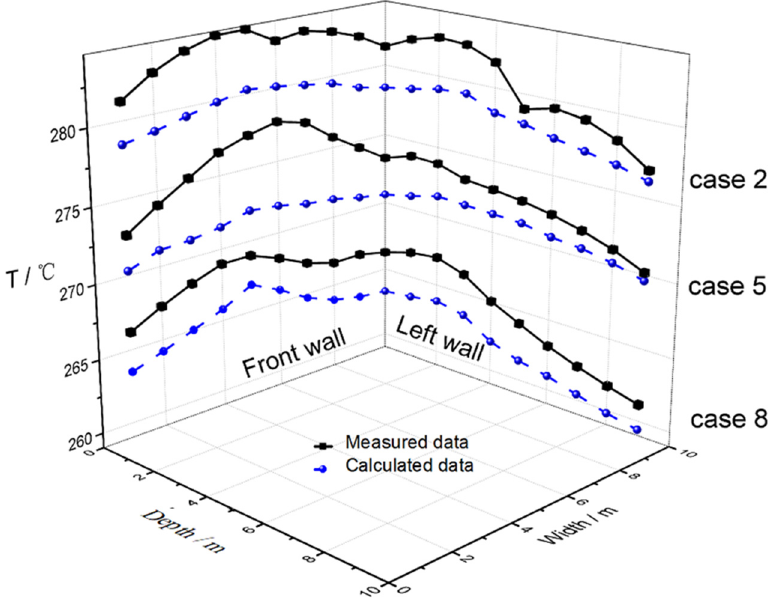
Figure 2. Comparison of temperatures on the front and left wall in case 2, case 5, and case 8.